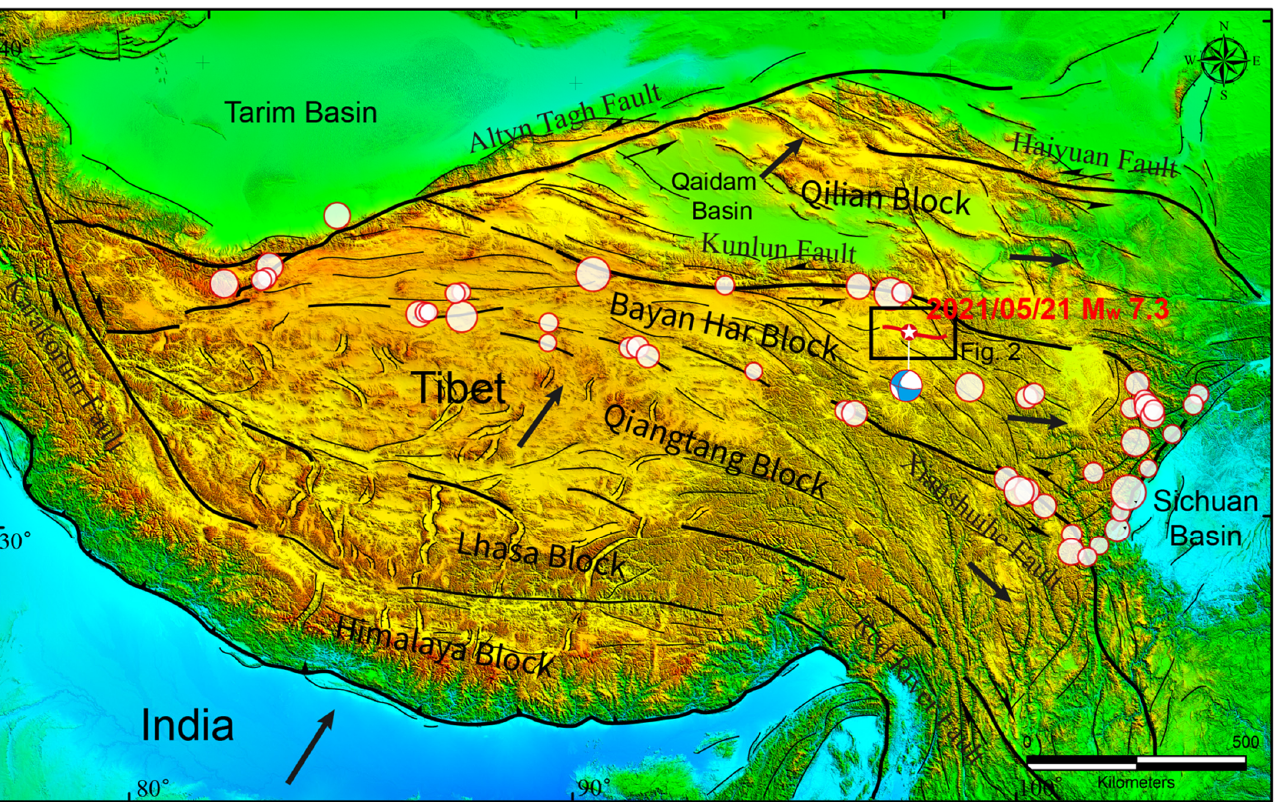
Figure 1. Active faults map of Tibet. Large fault zones (thick black lines) divide Tibet into several blocks. The red line represents the surface rupture, and the white star is the earthquake epicenter